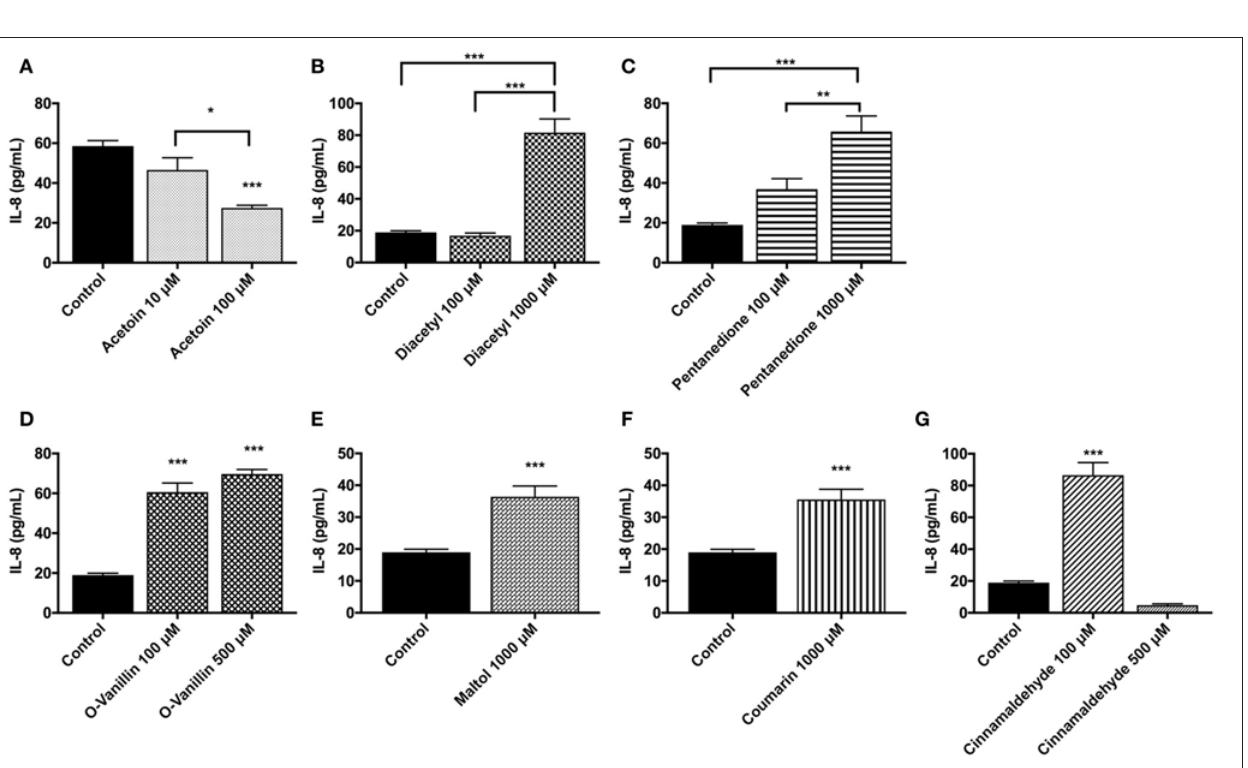
FIGURE 6 | Flavoring chemicals, (A) acetoin, (B) diacetyl, (C) pentanedione, (D) o-vanillin, (E) maltol (F) coumarin, and (G) cinnamaldehyde (at low and high doses between 10 and 1,000 μ M) induced pro-inflammatory cytokine, IL-8, response by U937 cells. U937 monocytes were treated with flavoring chemicals for 24h. Conditioned media was then assayed for IL-8 concentration by ELISA. Data are expressed as mean ± SEM. N = 4–6 per group. Statistical significance was determined by One-way ANOVA for multiple groups (Tukey’s comparisons test). * p < 0.05, ** p < 0.01, *** p < 0.001 vs. untreated control. Student t -test for comparing two groups. *** p < 0.001 vs. untreated